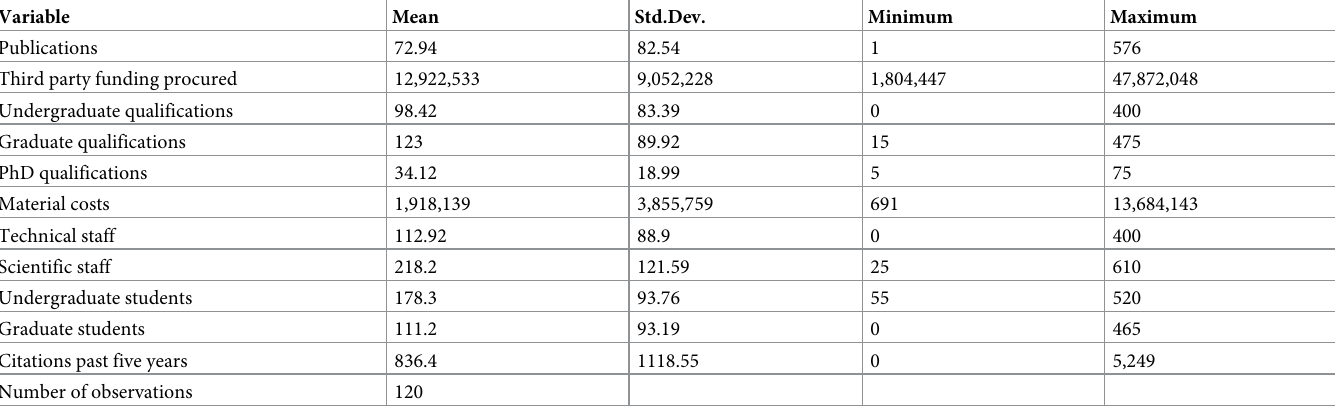
Table 4. Descriptive statistics for the agricultural science sample before imputation.